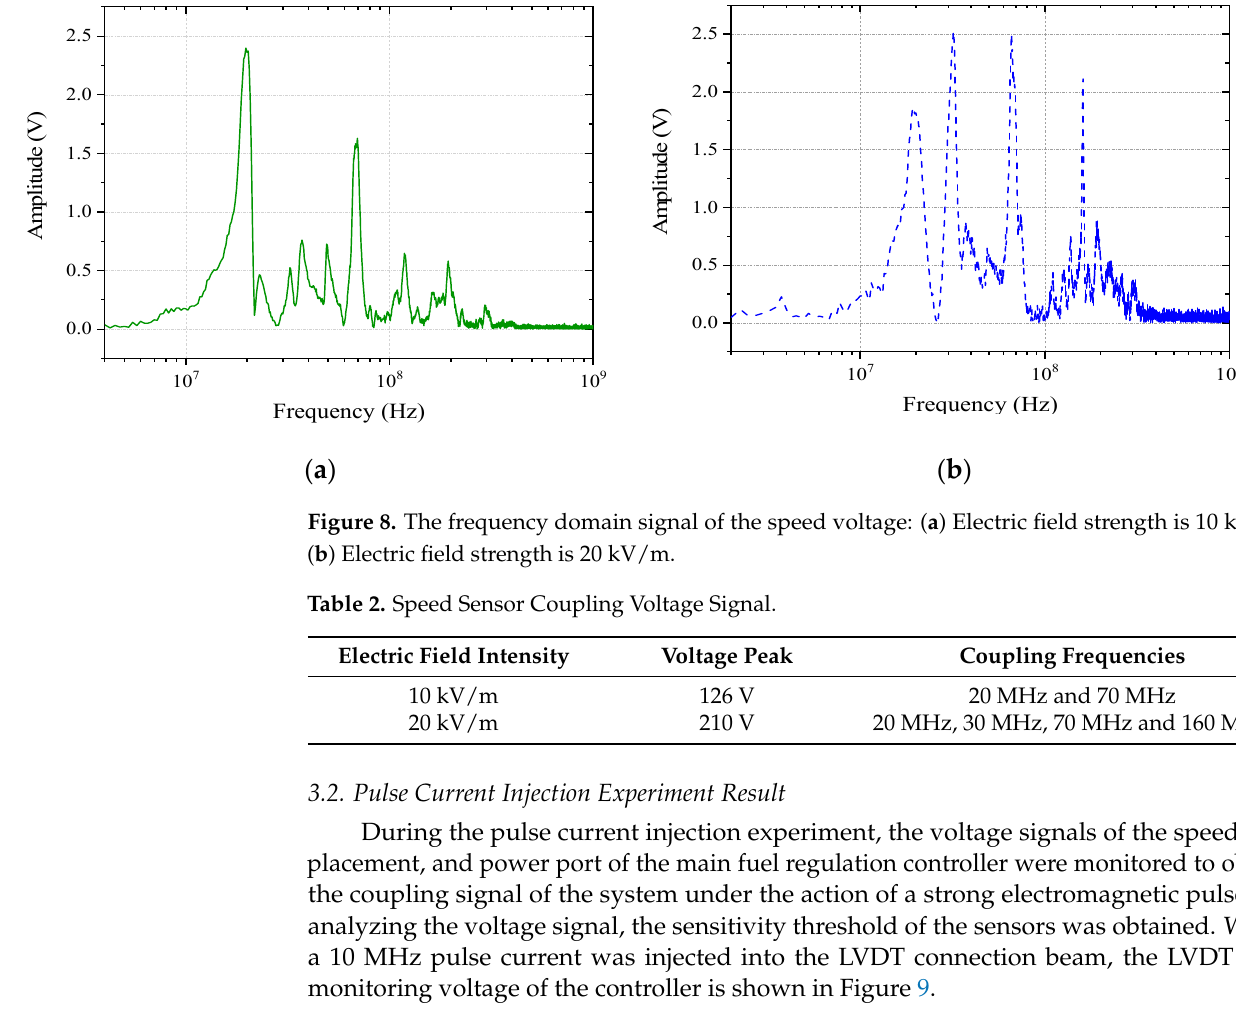
Figure 9. LVDT port monitoring voltage in 10 MHz current injection.